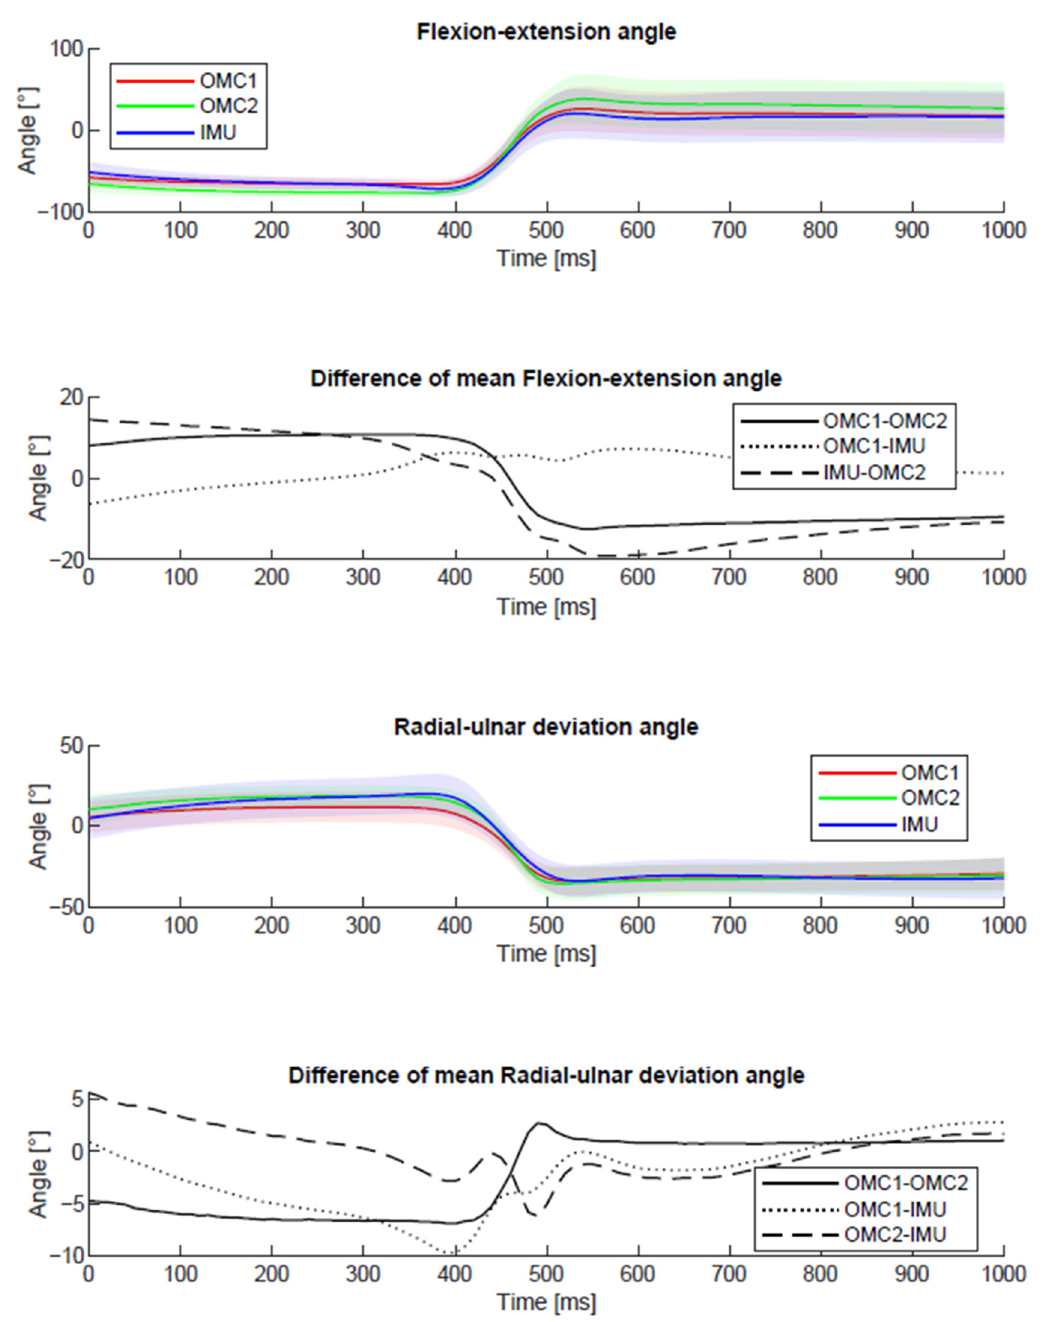
Figure A3. Visual representation of the effective angle curves and differences between the measurement methods during the trials.